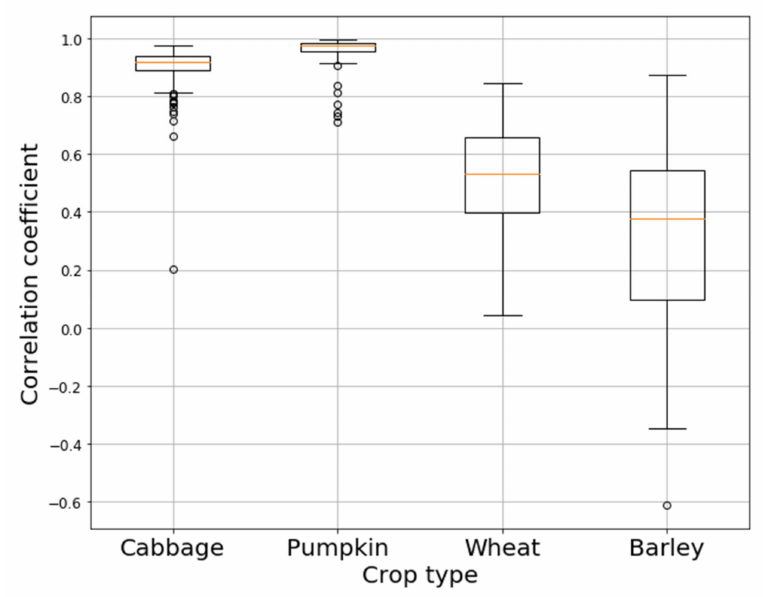
Figure 8. Boxplot of the correlation coefficient for the growth curves of individual plants generated from the UAV-estimated height and compared with the growth curves generated from the manual measurements over the complete growing season for cabbage, pumpkin, wheat, and barley